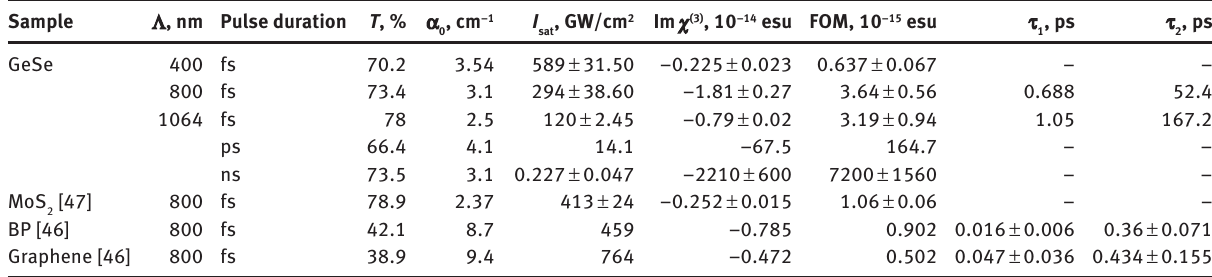
Table 1: Linear and nonlinear optical coefficients of GeSe dispersions measured by the Z-scan technique and femtosecond transient optical absorption